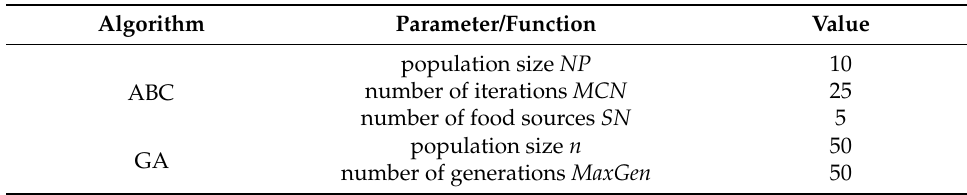
Table 4. ABC-GA hybrid algorithm—parameters and functions.